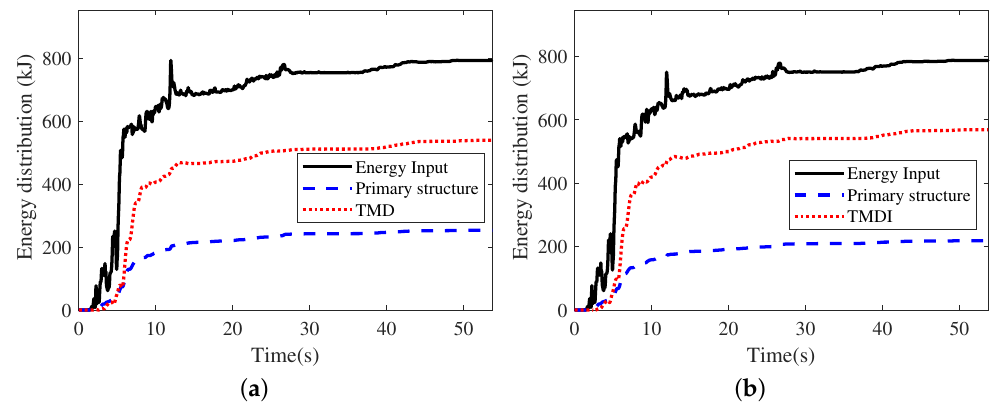
Figure 12. The energy consumption for TMD and TMDI under EL Centro wave: ( a ) TMD and ( b )